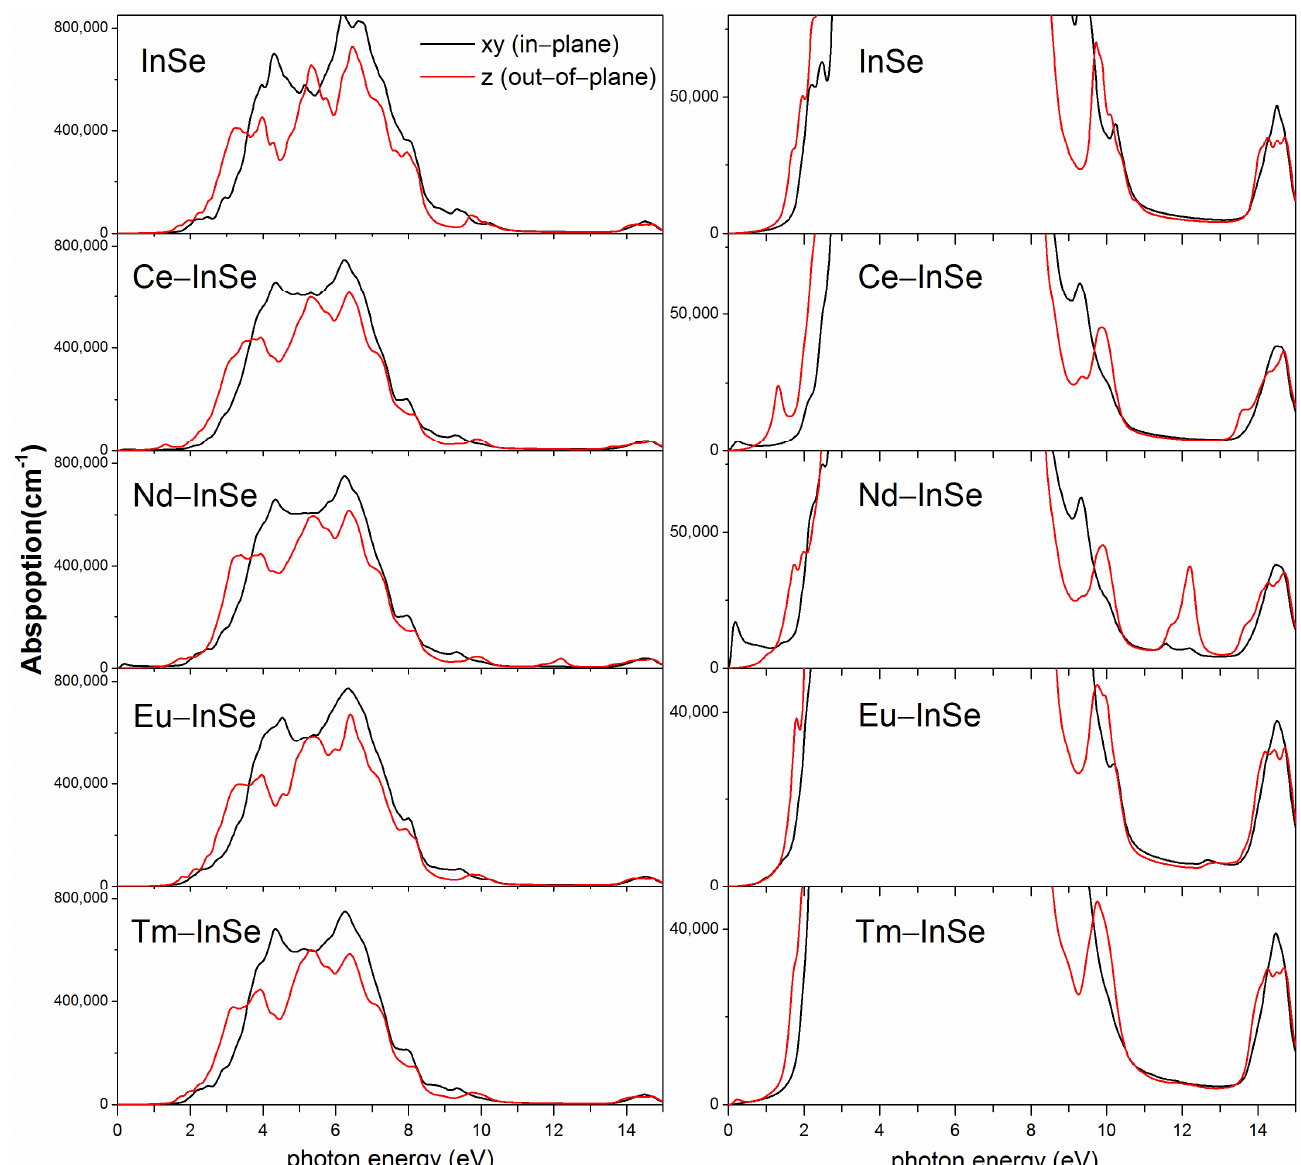
Figure 5. The calculated optical response of the absorption for the pristine InSe monolayer and the four lanthanides (Ce, Nd, Eu, Tm) doped systems, with E − field polarization, parallel to the xy − plane (black line) and out − of − plane z direction (red line).